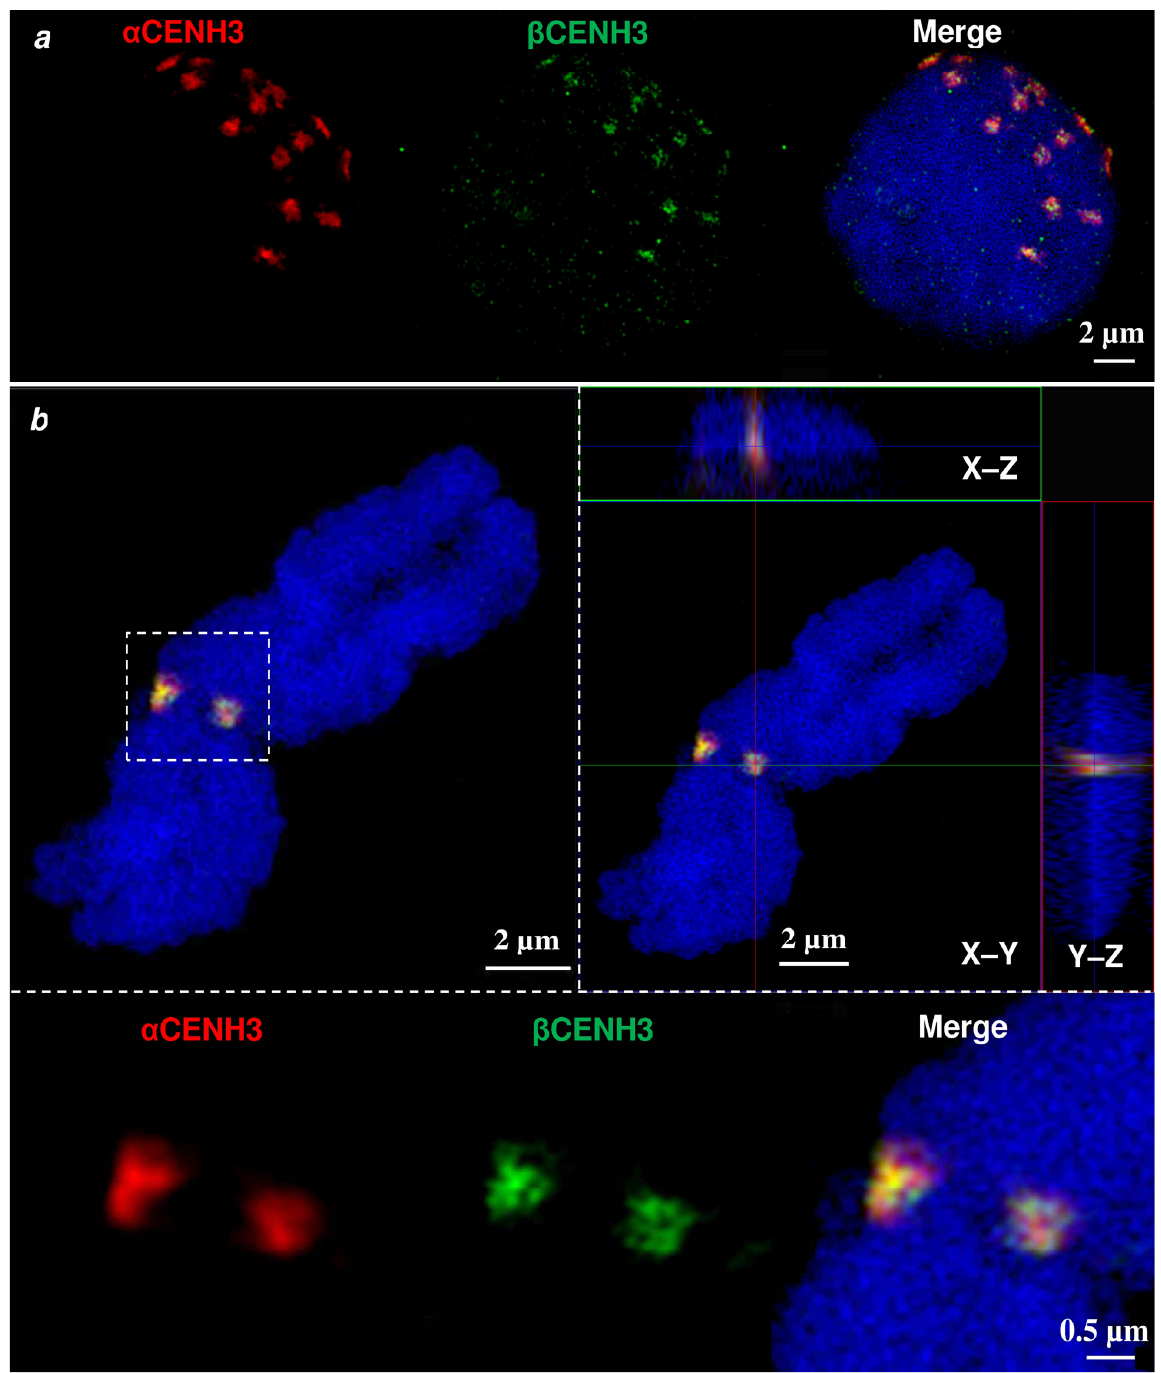
Figure 5. α CENH3 and β CENH3 localization in the centromeres of interphase nuclei ( a ) and metaphase chromosomes ( b ) of rye. The increased resolution achieved via SIM reveals that both CENH3 variants colocalize and intermingle. ( a ) The centromere concentration at the top-right clearly visualizes the Rabl orientation in the nucleus. ( b ) The orthoview (right) indicates the spatial distribution of CENH3 within the centromere. Below, the centromeric region (dashed rectangle) is shown enlarged.